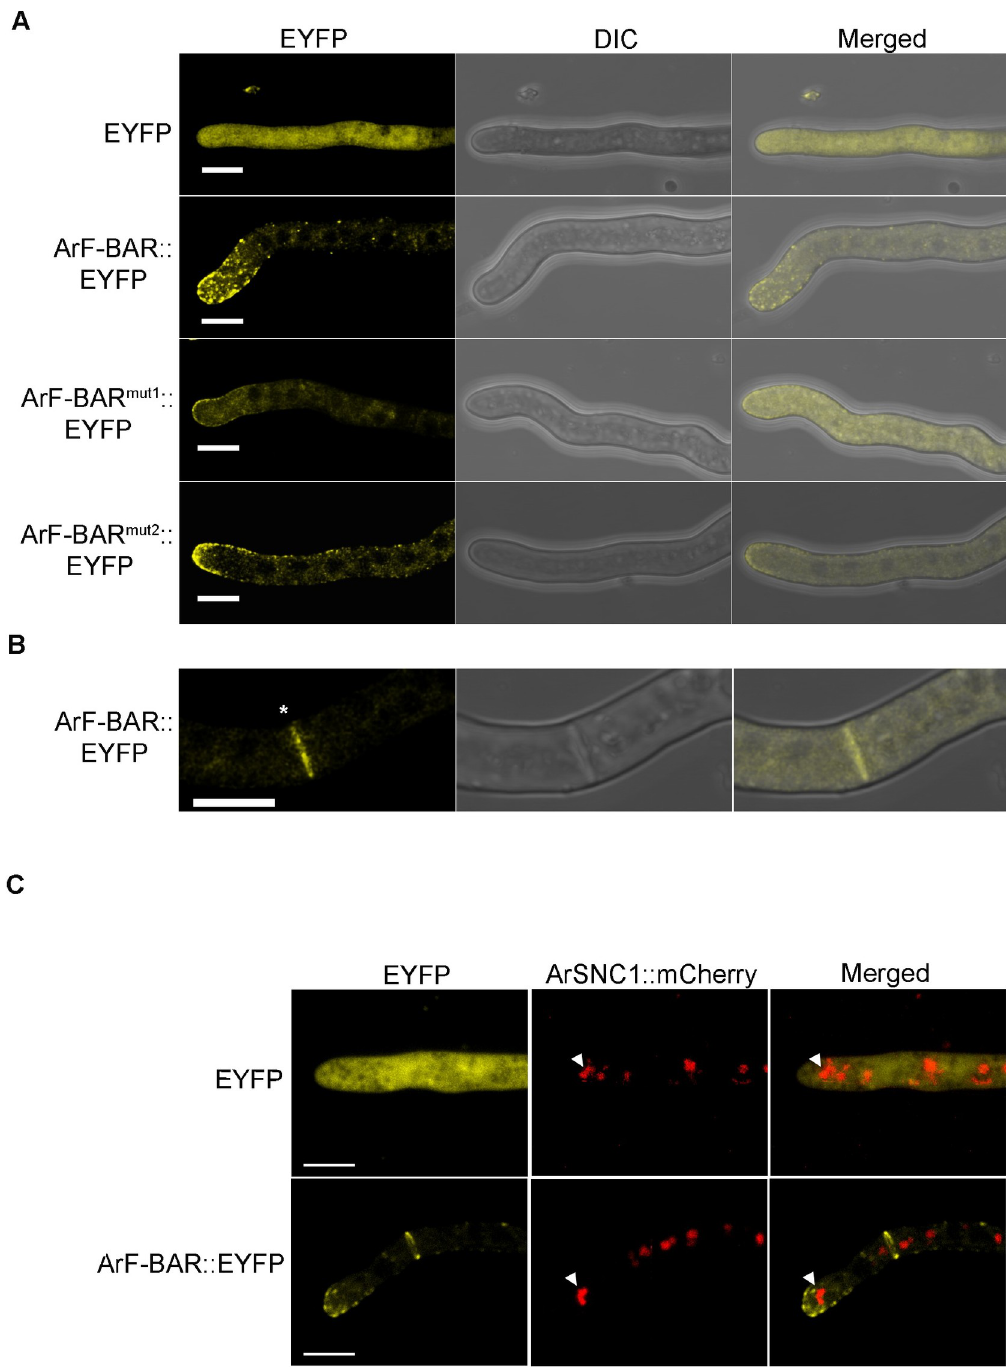
Fig 4. ArF-BAR primarily decorates the growing hyphal tip. (A) Ectopically expressed ArF-BAR::EYFP and ArF-BAR mut2 :: EYFP chimeric proteins are distributed at the hyphal tip. Fungal cells expressing ArF-BAR mut1 ::EYFP had fluorescence scattered throughout the fungal hyphae. The representative images were captured at 12 h post germination of fungal conidia on microscopic coverslip. Scale bar = 5 μ m. (B) ArF-BAR::EYFP signal is uniformly distributed at fungal septum, scale bar = 5 μ m. Star represents the hyphal septum. (C) The growing hyphal tip localization of ArF-BAR::EYFP was examined along with A . rabiei Spitzenko¨rper marker, ArSNC1::mCherry. Arrowhead represents the localization of ArSNC1. The v-SNARE SNC1 along with other proteins mediate docking and fusion of vesicles with the plasma membrane target site. Micrographs show representative images of three biological replicates with at least 10 images in each